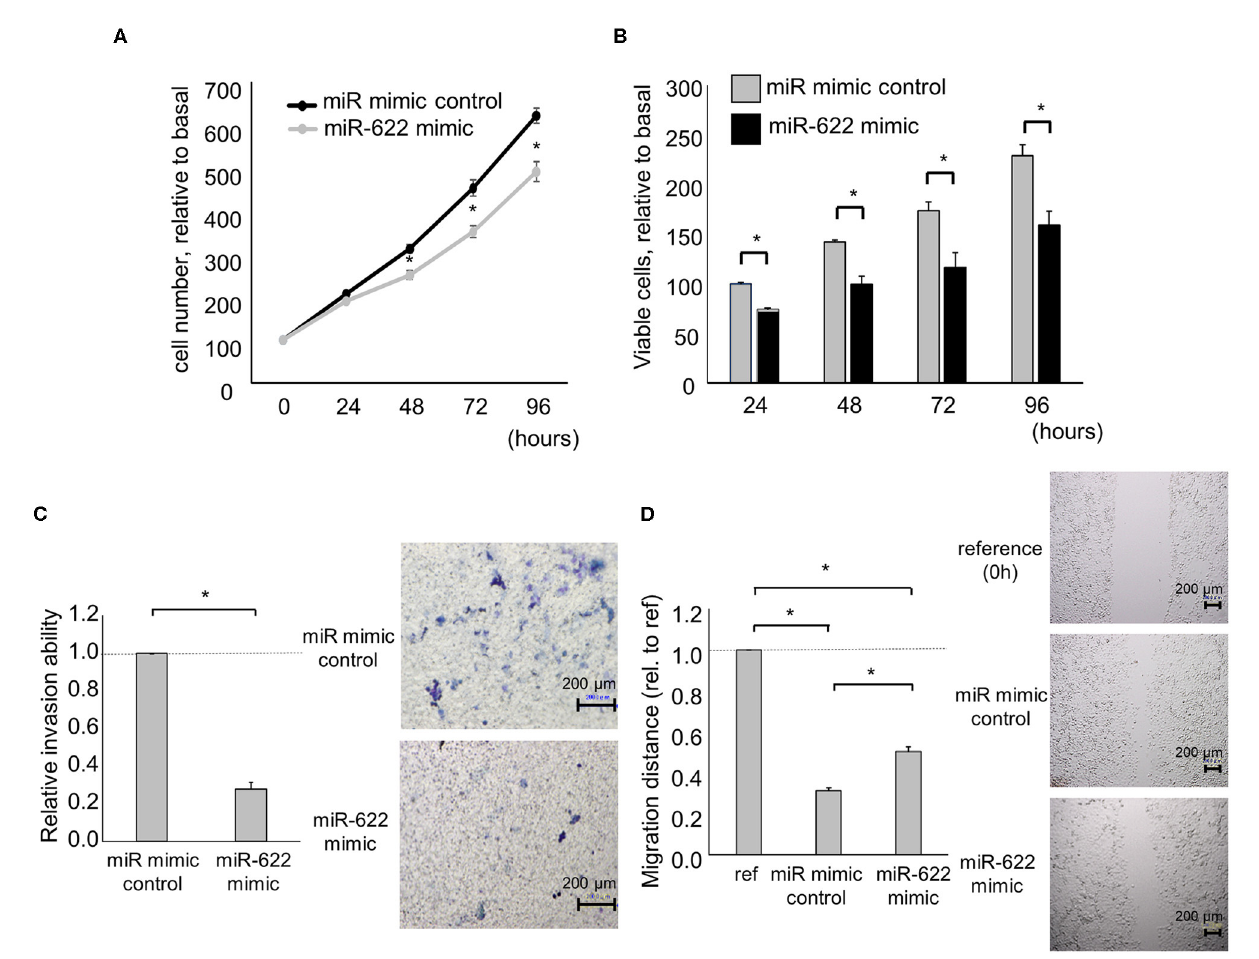
FIGURE 3 | Effect of miR-622 overexpression on the phenotype of PDAC cells. Panc-1 cells were transfected with 12.5nM miR-622 or the control mimic. (A,B) After 24, 48, 72, and 96h, cell proliferation was assessed by cell counting using trypan blue (A) and cell viability was investigated by MTS assay (B) . (C) After 24h, cell invasion was examined by Transwell assay using an inverted microscope. (D) After 24h, cell migration was examined by wound healing assay. Reference indicates the image at time zero. Bars are the means ± SEM of three independent experiments. * P < 0.05.